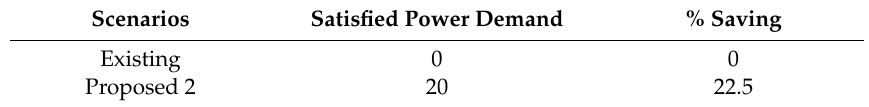
Figure 14. Comparison of satisfied power demand management between proposed-2 and existing scenario over 24 h time horizon.